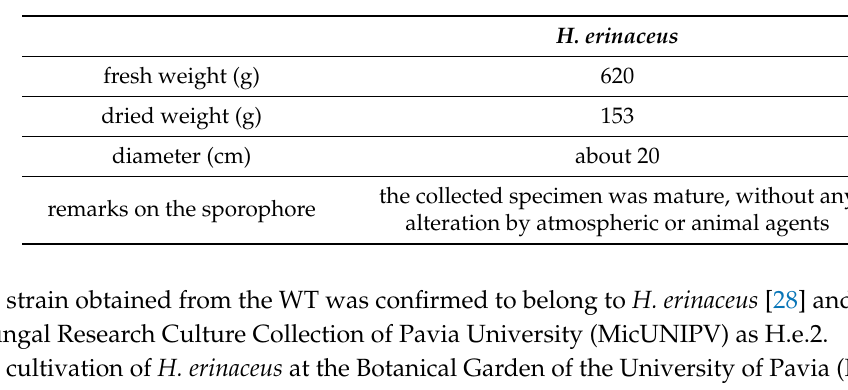
Table 1. Characteristics of Hericium erinaceus wild type